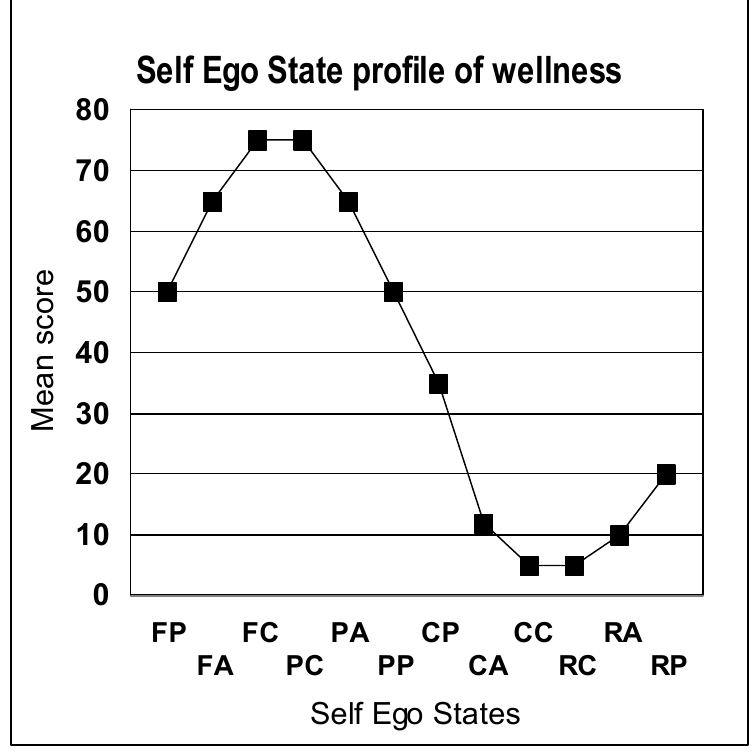
Figure 3: Self Ego state profile of